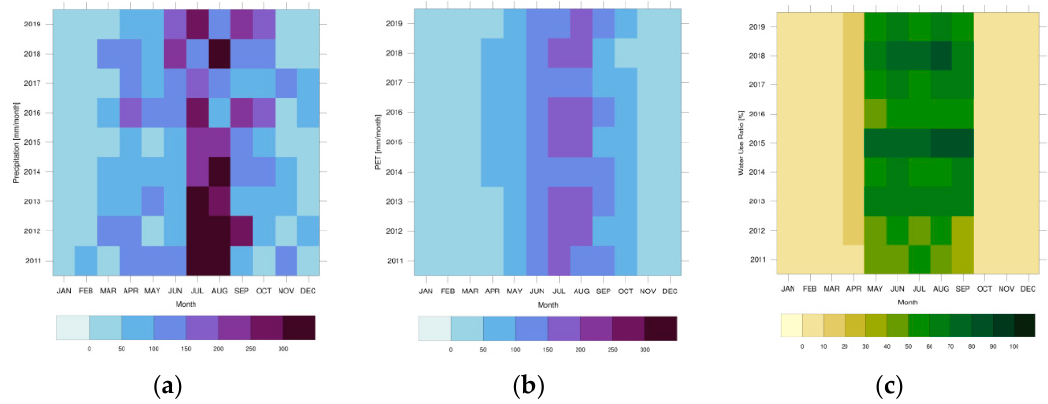
Figure 5. Matrix plot for monthly ( a ) precipitation, ( b ) potential evapotranspiration, and ( c ) stream water-use rate, from 2011 to 2019.